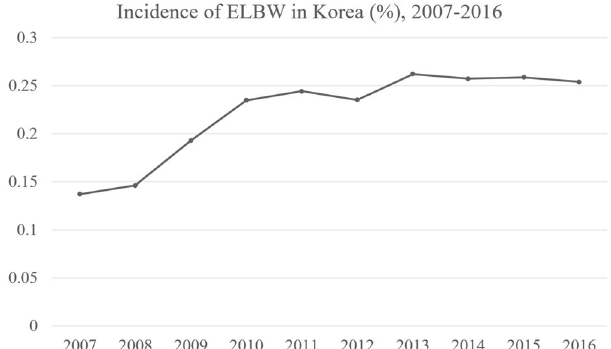
Figure 1. Incidence of extremely low birth weight (ELBW) infants in Korea (total ELBW newborns/total newborns yearly), 2007–2016, raw data from Statistics